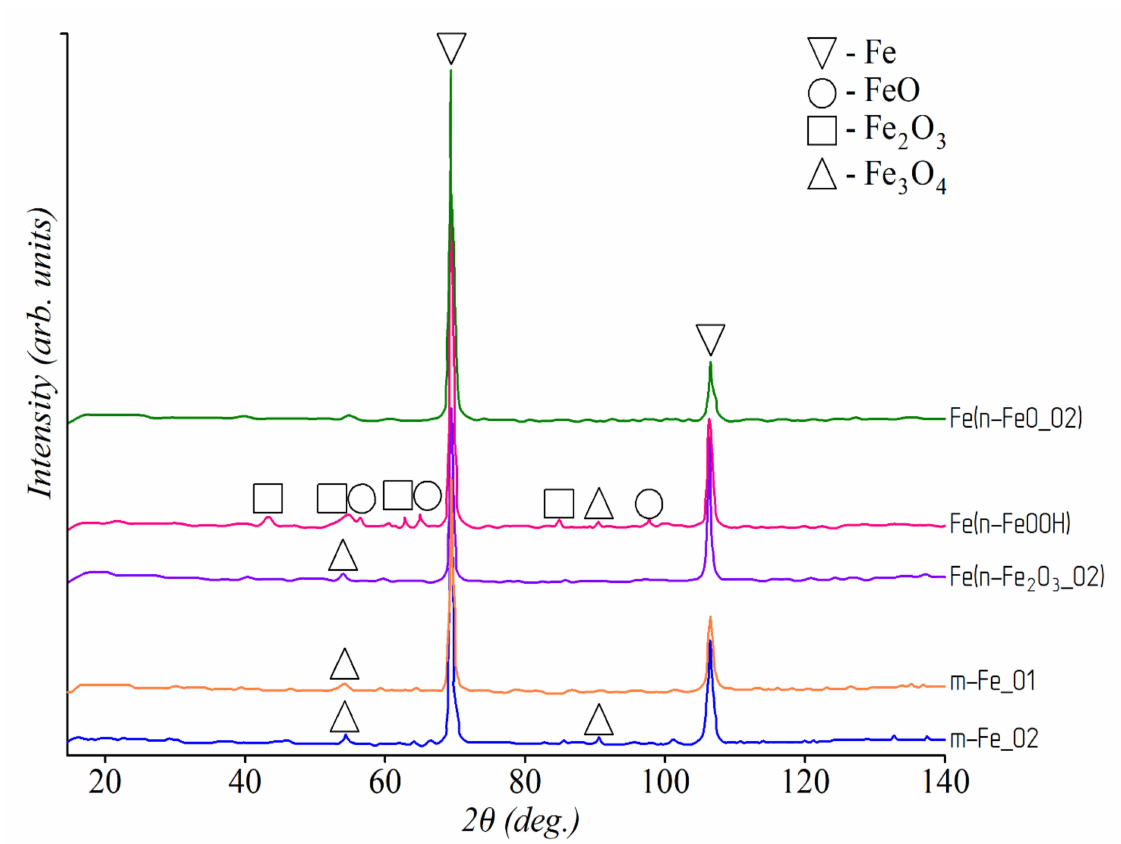
Figure 1. XRD patterns of studied iron powder